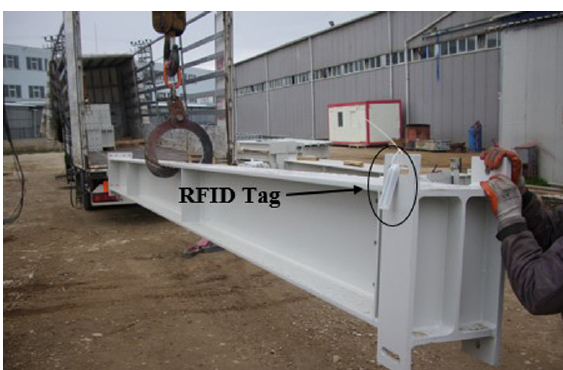
Fig. 4. Steel assembly with an RFID